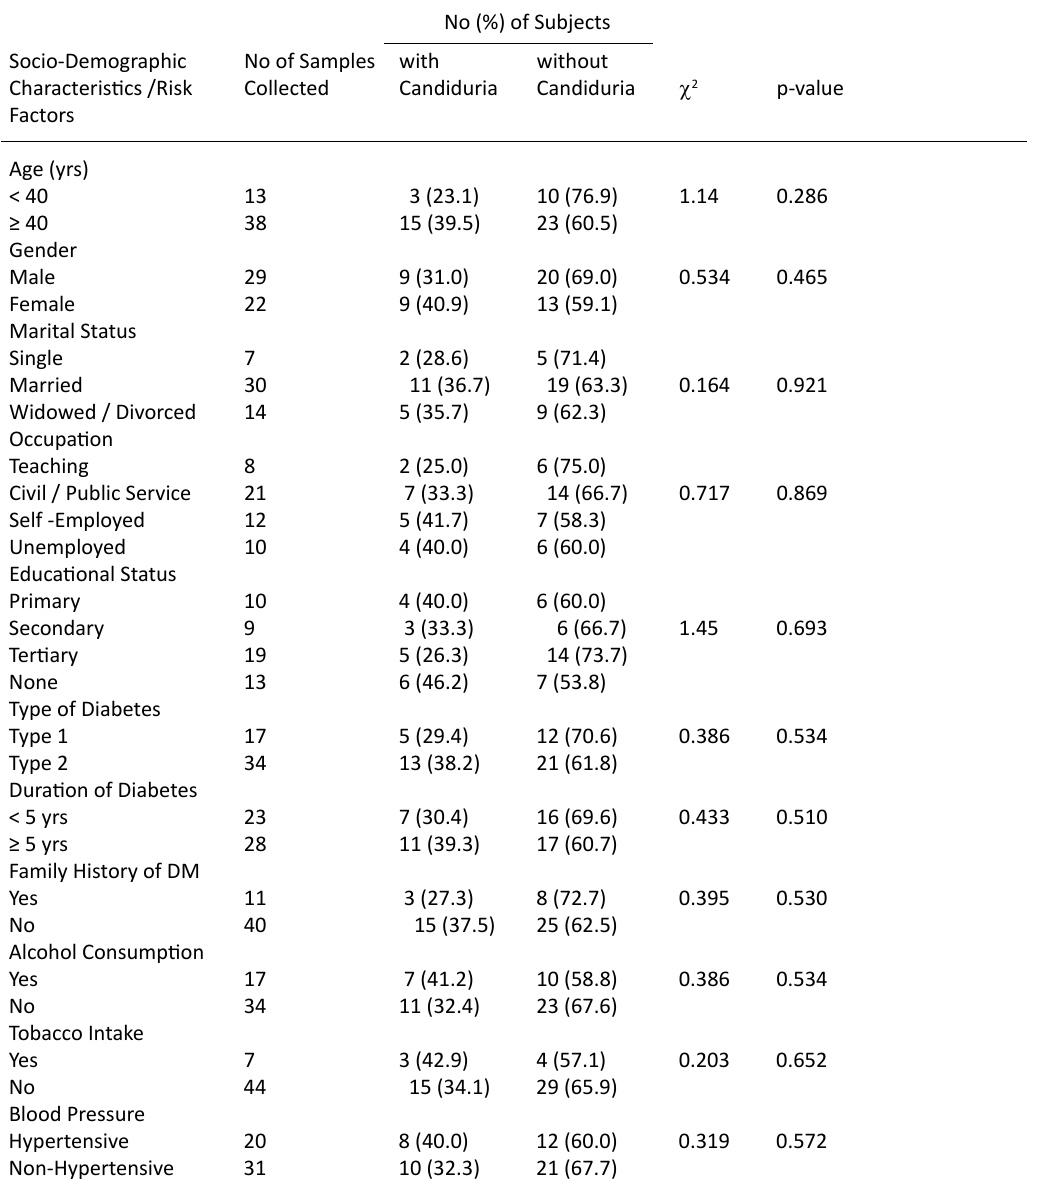
Table 3. Socio-Demographic Characteristics and Risk Factors of Diabetic Patients No (%) of Subjects Socio-Demographic No of Samples with